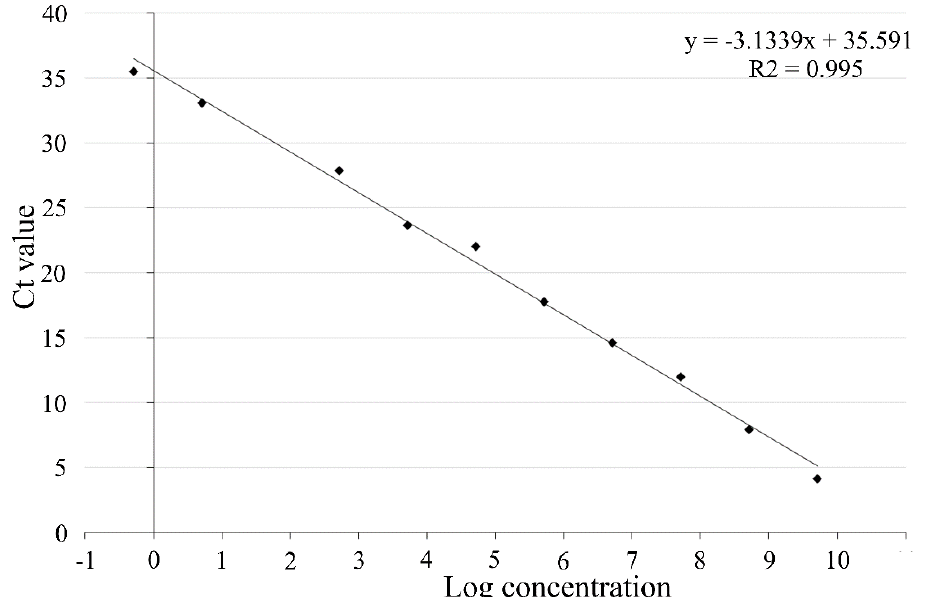
Figure2. Molecularstandardcurvegeneratedbyreal-timePCRforRpoBprimersetthroughSYBR-green qPCR. Target DNA ranged from 10 9 to 10 − 1 copies. Figure 2. Molecular standard curve generated by real-time PCR for RpoB primer set through SYBR- green qPCR. Target DNA ranged from 10 9 to 10 − 1 copies.